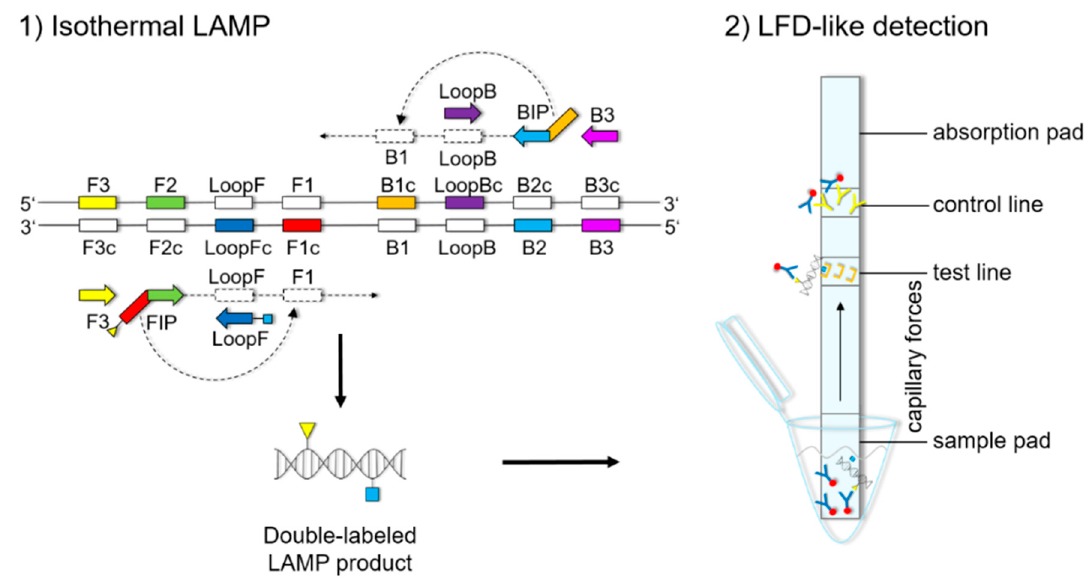
Figure 1. Localization of individual LAMP primers, including FITC and biotin-labeled LoopF and FIP primers, respectively, leading to a double-labeled LAMP product that is detected using a lateral flow dipstick (LFD). Illustrations of LAMP product formation are detailed elsewhere [18–20]. FITC- and biotin-labeled LAMP products, loaded by gold particles via an FITC-specific gold-labeled antibody, are captured on the test line by the biotin label. Free gold-labeled antibodies are captured at the control line. Table 3. LAMP primers and 18S-eukaryote PCR primers used in this study (except for 18S rRNA, all primers were developed in this study).